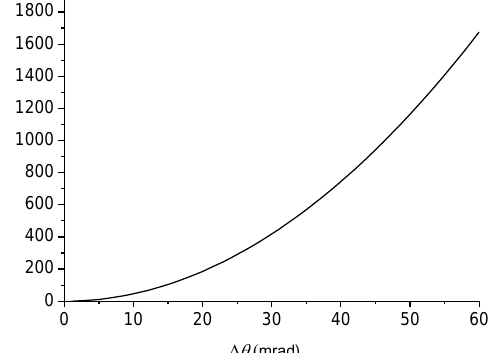
Figure 1. Dependence of the angular GH shift on the diffraction angular divergence of the beam. The polarization affects the width of the beam propagating in the waveguide. Below,